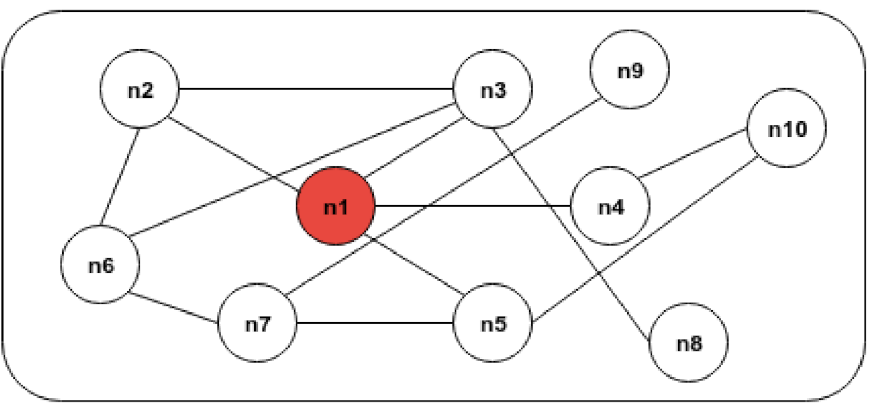
Figure 8. Structural issue of the matching process: the node’s connecting structure depends on the market’s thickness. All other modes can still find matches even if node N 1 matches any of its connected neighbors